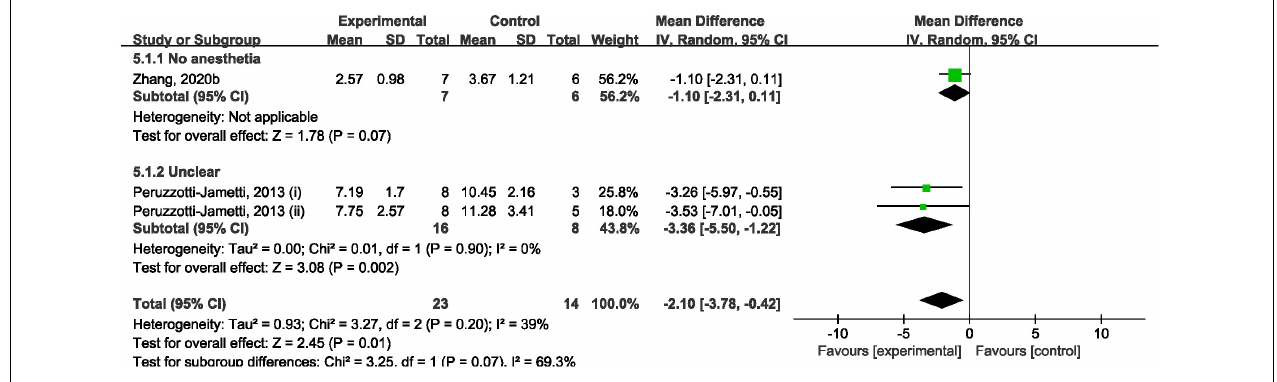
FIGURE 5 | Forest plot analysis of the efficacy of cathodal tDCS on mNSS compared to controls divided on anesthesia used during tDCS procedure.